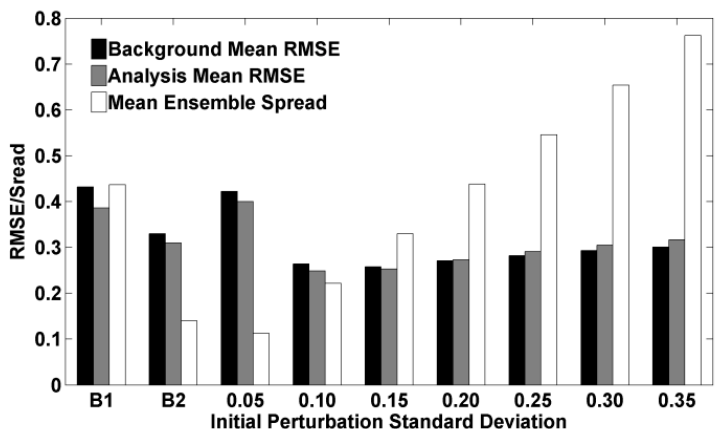
Figure 8. The mean RMSEs and ensemble spread of the DRP-4DVar method using initial random perturbation for each assimilation window with standard deviation of 0.05~0.35. Other assimilation parameters of the DRP-4DVar experiments are the same as those of the DRP-4DVar experiment in Exp-1. The mean RMSEs and ensemble spread of the ETKF and the 4DEnVar methods in Exp-1 are used as benchmarks, which are noted as B1 and B2, respectively. The ensemble spread of the DRP-4DVar and the 4DEnVar methods refers to the average of the ensemble spreads during an assimilation window. The black bars, gray bars, and white bars denote the mean background RMSE, the mean analysis RMSE and the mean ensemble during the last 500 time steps, respectively.